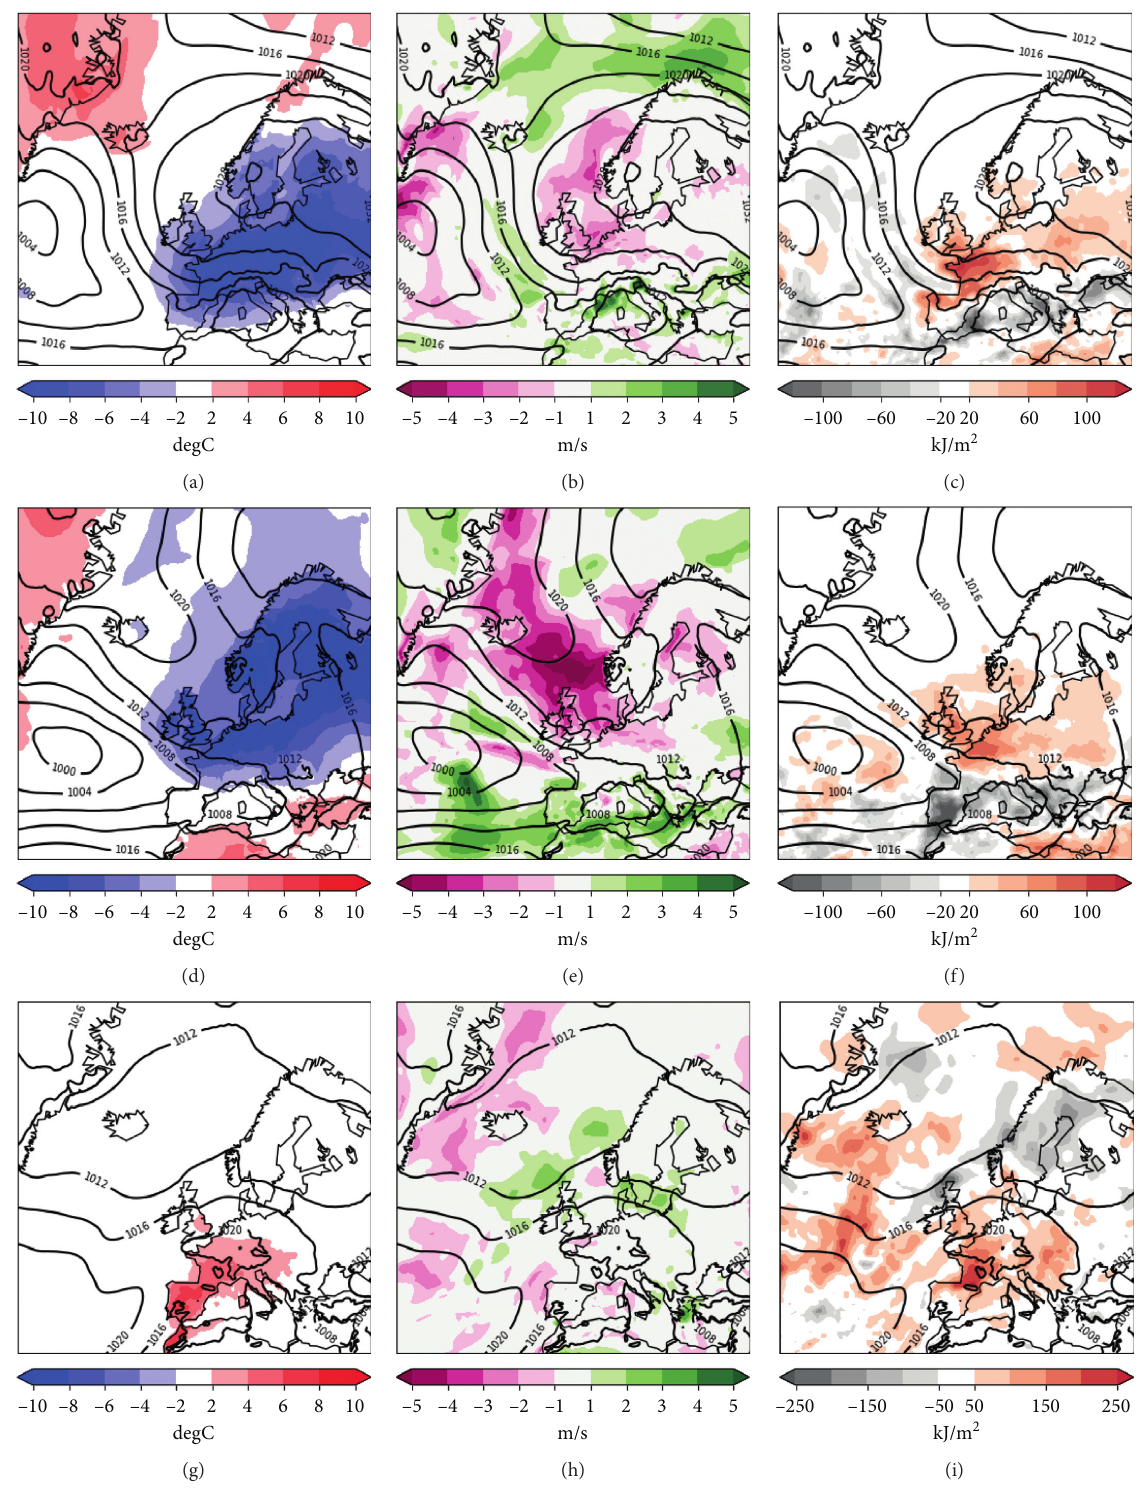
Figure 3: Meteorological anomaly composites of the top 10 peak demand events for (a–c) France, (d and f), the UK, and (g and h) Spain. Columns show (left) 2m temperature, (middle) 100m wind speed, and (right) surface solar radiation. Note different scales in (i) relative to (c) and